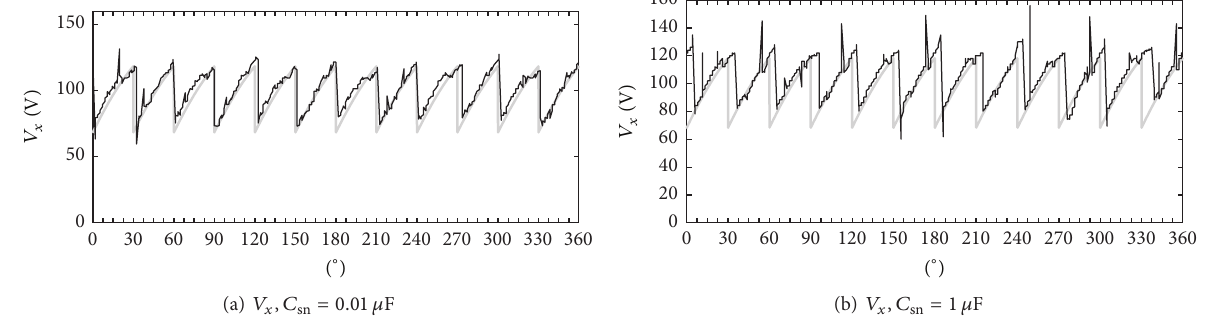
Figure 30: 12-pulse DC voltage waveform 𝑉 𝑥 .